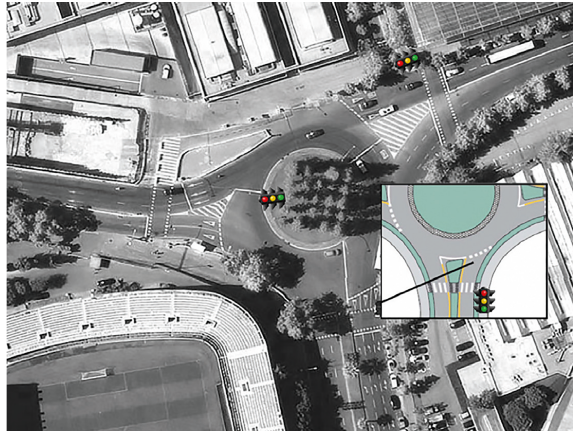
Figure 2: TLSR-2SL real-world